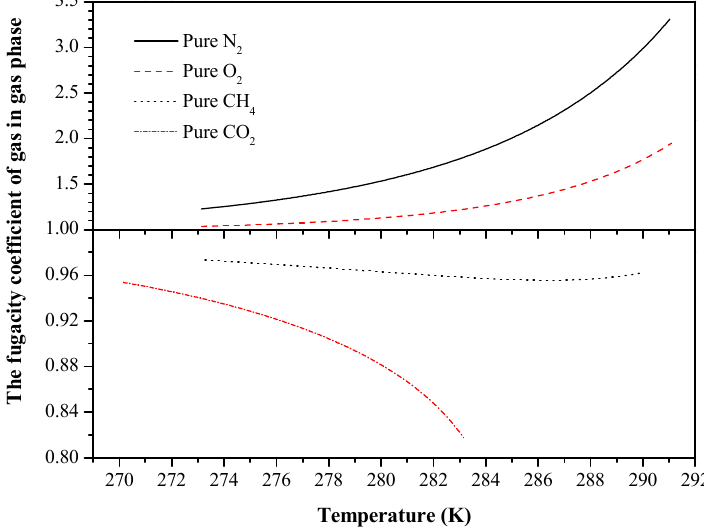
Figure 2. The fugacity coefficient of CH 4 , CO 2 , N 2 and O 2 in vapor phase.